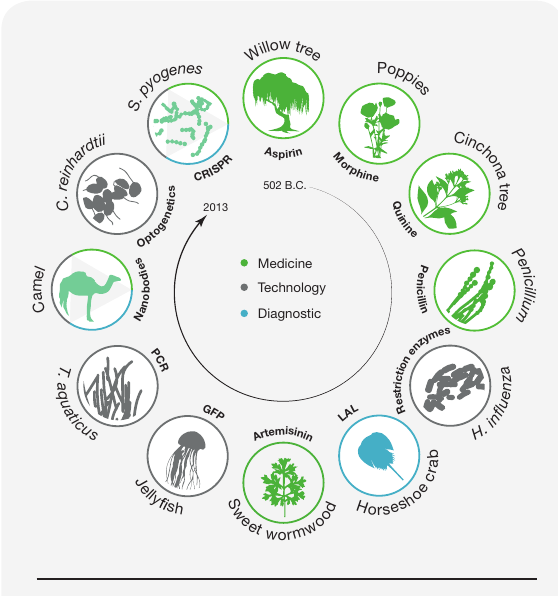
Figure 1. Human health has benefi tted from natural diversity in myriad ways, including the development of medicine, molecular technologies, and diagnostics. LAL, Limulus amebocyte lysate (used for the detection of endotoxins); GFP, green fl uorescent protein; PCR, polymerase chain reaction; CRISPR, Clustered Regularly Interspaced Palindromic Repeats.